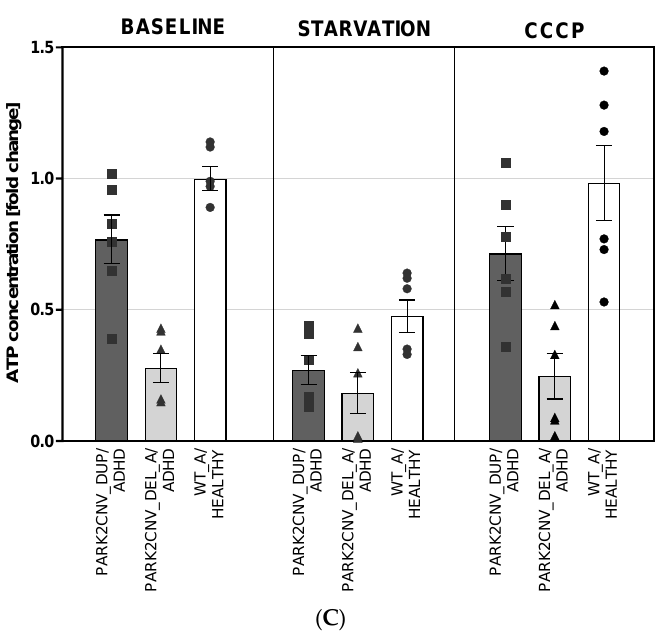
Figure 3. ( A – C ): ATP quantification. Cellular ATP content was evaluated in HDF lines ( A , B ) and in mDANs ( C ) in baseline conditions, after 24-h starvation stress and after treatment with 10µM CCCP for 24 h. Fold difference was calculated against WT in baseline conditions. Data were obtained from two independent experiments with samples measured in triplicate. Data are shown as mean ± SEM. Exploratory ANOVA was calculated. Figure A shows the data of HDF cell lines from PARK2 CNV duplication vs. deletion vs. wildtype healthy control separately, Figure B shows a combined analysis of PARK2 CNV deletion + duplication vs. wildtype ADHD + healthy to increase number of HDF cell lines and statistical power. Level of significance was set at p = 0.05. * p ≤ 0.05; ** p ≤ 0.01; *** p ≤ 0.001.